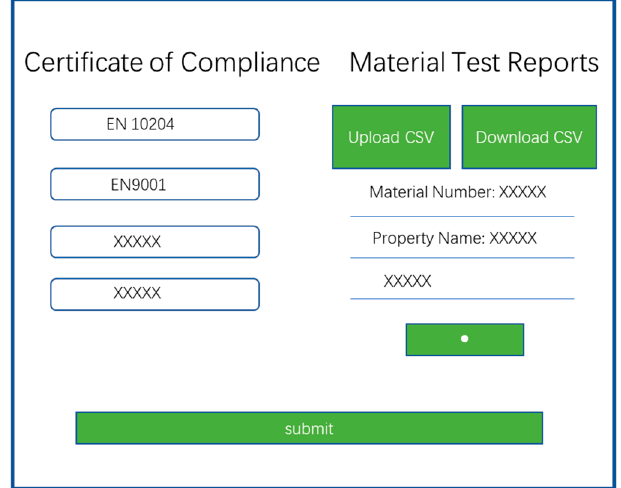
Figure 6. Material traceability record. (Adapted with permission from ref. [29]. 2021 Copyright Khalid Farrag).